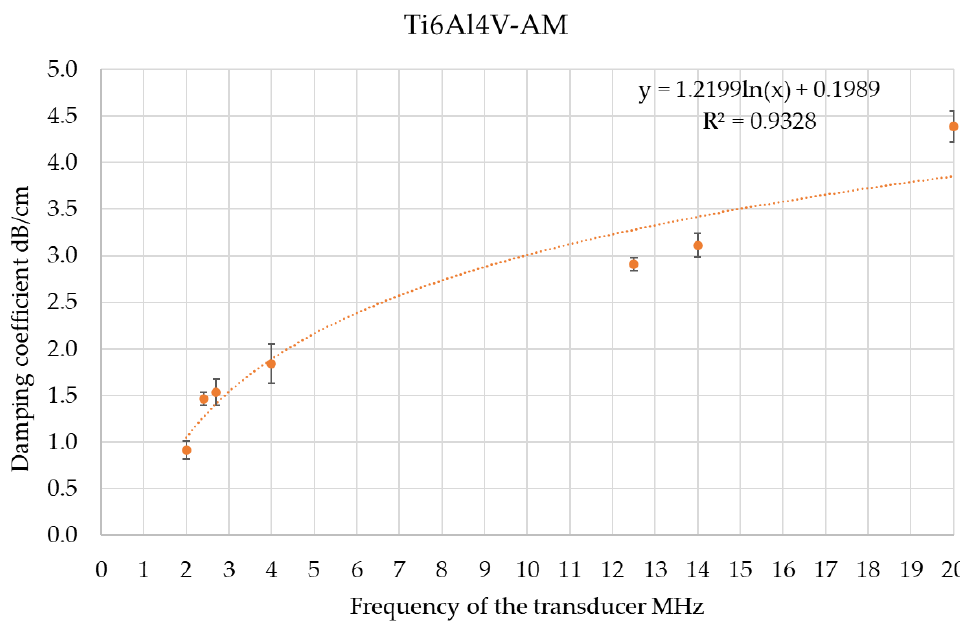
Figure 5. Dependence of the ultrasonic transducer frequency on damping coefficient for Ti6Al4V- AM material.